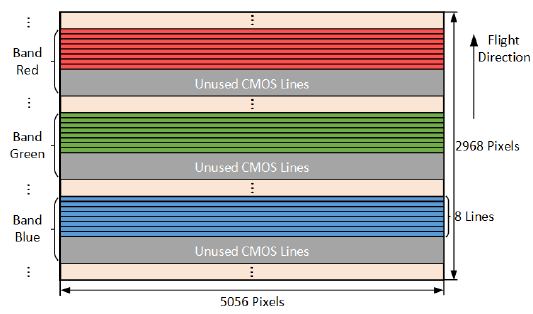
Figure 4. One CMOS sensor in Zhuhai-1 imaging system. Each band is captured by eight lines with a different location.